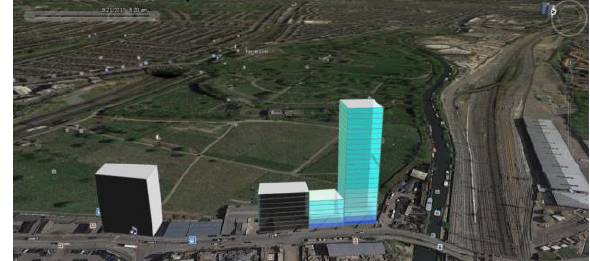
Figure 7 The air quality model at 8.20 am as seen from the south-east side of the